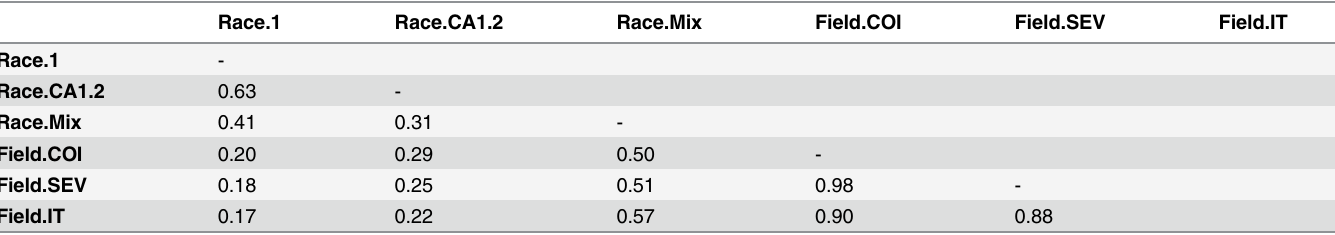
type IT). The field response and response to single races are less well correlated (R < 0.29), Table 1. Phenotype correlations among field and seedling traits (Race.1, Race.CA1.2, Race.Mix, Field.COI, FIELD.SEV, FIELD.IT). Race.1 Race.CA1.2 Race.Mix Field.COI Field.SEV Field.IT